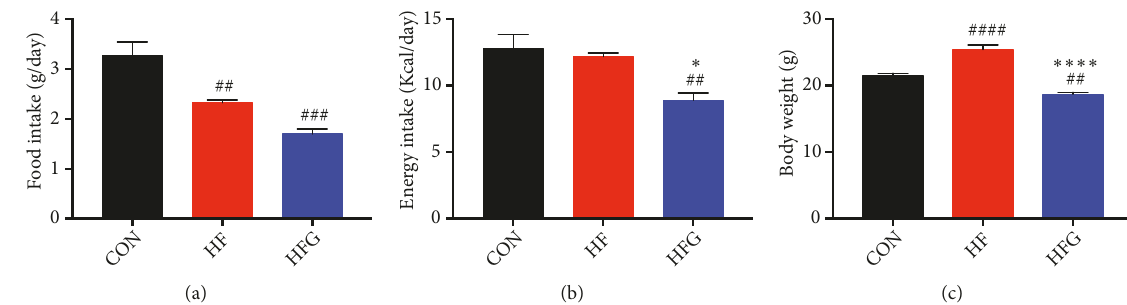
Figure 1: Dietary genistein could reduce energy intake and body weight in mice fed a high-fat diet. (a) Mean food intake during the experimental period expressed as grams per day; (b) mean energy intake expressed as kcal per day; (c) body weight by the end of the study. CON: normal control diet; HF: high-fat diet without genistein; HFG: high-fat diet with genistein. Data are expressed as means ± S.E.M. (n=8/group). Mean values were significantly different between other groups and the CON group: # p < 0.05; ## p < 0.01; ### p < 0.001; #### p < 0.0001. Mean values were significantly different between HF group and the HFG group: ∗ p < 0.05, ∗∗ p < 0.01, ∗∗∗ p < 0.001, ∗∗∗∗ p <